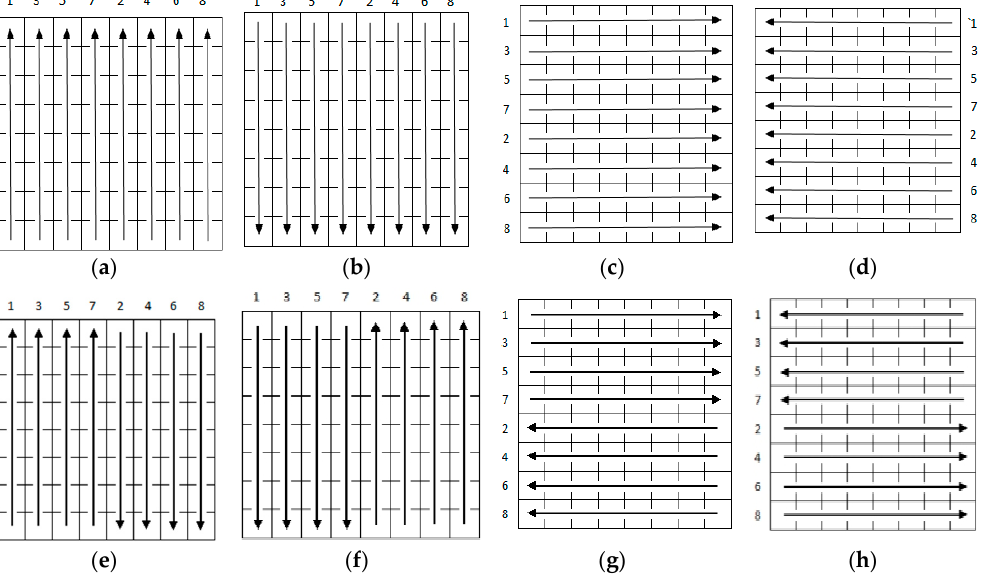
Figure 4. Eight patterns ( a ) Straight Up (SU), ( b ) Straight Down (SD), ( c ) Straight Forward (SF), ( d ) Straight Backward (SB), ( e ) Flipped Down (FD), ( f ) Flipped Up (FU), ( g ) Flipped Forward (FF), ( h ) Flipped Backward (FB).